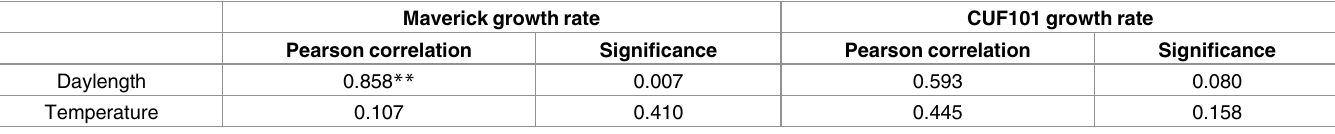
Table 2. Correlation of the growth rate with daylength and temperature in Maverickand CUF101